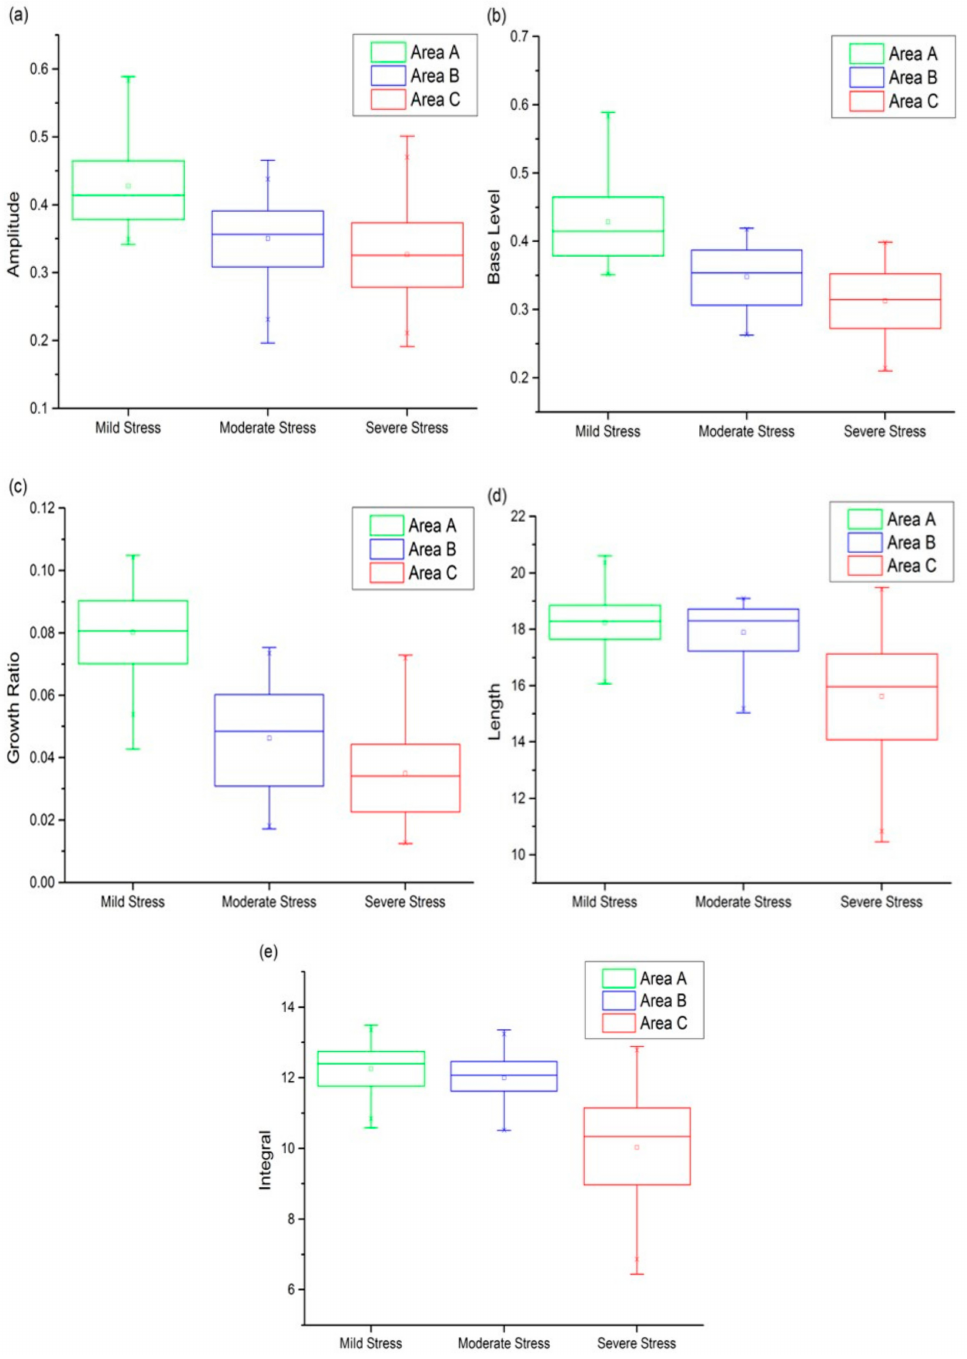
Figure 7. The comparison of five phenological indicators including ( a ) seasonal amplitude, ( b ) base level, ( c ) growth ratio, ( d ) length of season and ( e ) seasonal integral for analyzing heavy metal stress levels in